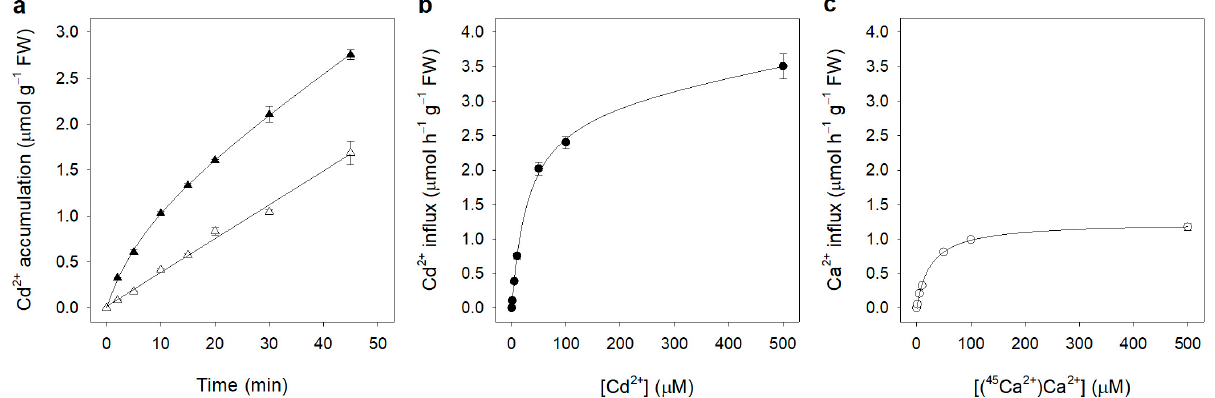
Figure 1. ( a ) Time-course of Cd 2+ accumulation in maize root segments. Root segments were incubated in the presence of 50 µM CdCl 2 for 2,5,10,15,20,30 and 45 min. At the end of the incubation, root segments were washed twice in water (filled triangles) or in 1 mM LaCl 3 (open triangles). The amount of spurious Cd 2+ present in the root segments before incubation was negligible (0.18 ± 0.04 nmol g − 1 FW). ( b ) Kinetic of Cd 2+ influx in maize root segments. Root segments were incubated for 15 min in the presence of 1,5,10,50,100 and 500 µM CdCl 2 , harvested, washed twice with 1 mM LaCl 3 (at 2 °C), mineralized, and the mineralization liquid was assayed for Cd 2+ content using atomic absorption spectrophotometry (see Methods). ( c ) Kinetic of Ca 2+ influx in maize root segments. Root segments were incubated for 15 min in the presence of 1,5,10,50,100 and 500 µM ( 45 Ca 2+ )CaCl 2 . At the end of incubation, the segments were harvested, washed twice with 1 mM CaCl 2 (non-labelled, at 2 °C), and radioactivity was measured using liquid scintillation spectrometry. Data are means ± SD of three independent experiments run in triplicate ( n = 3).